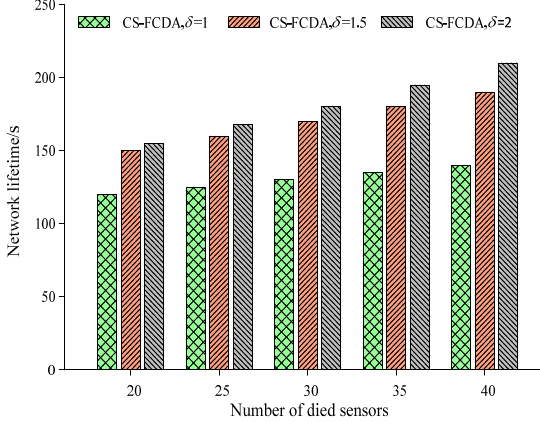
Figure 9. Comparison on network lifetime with different network clustering.